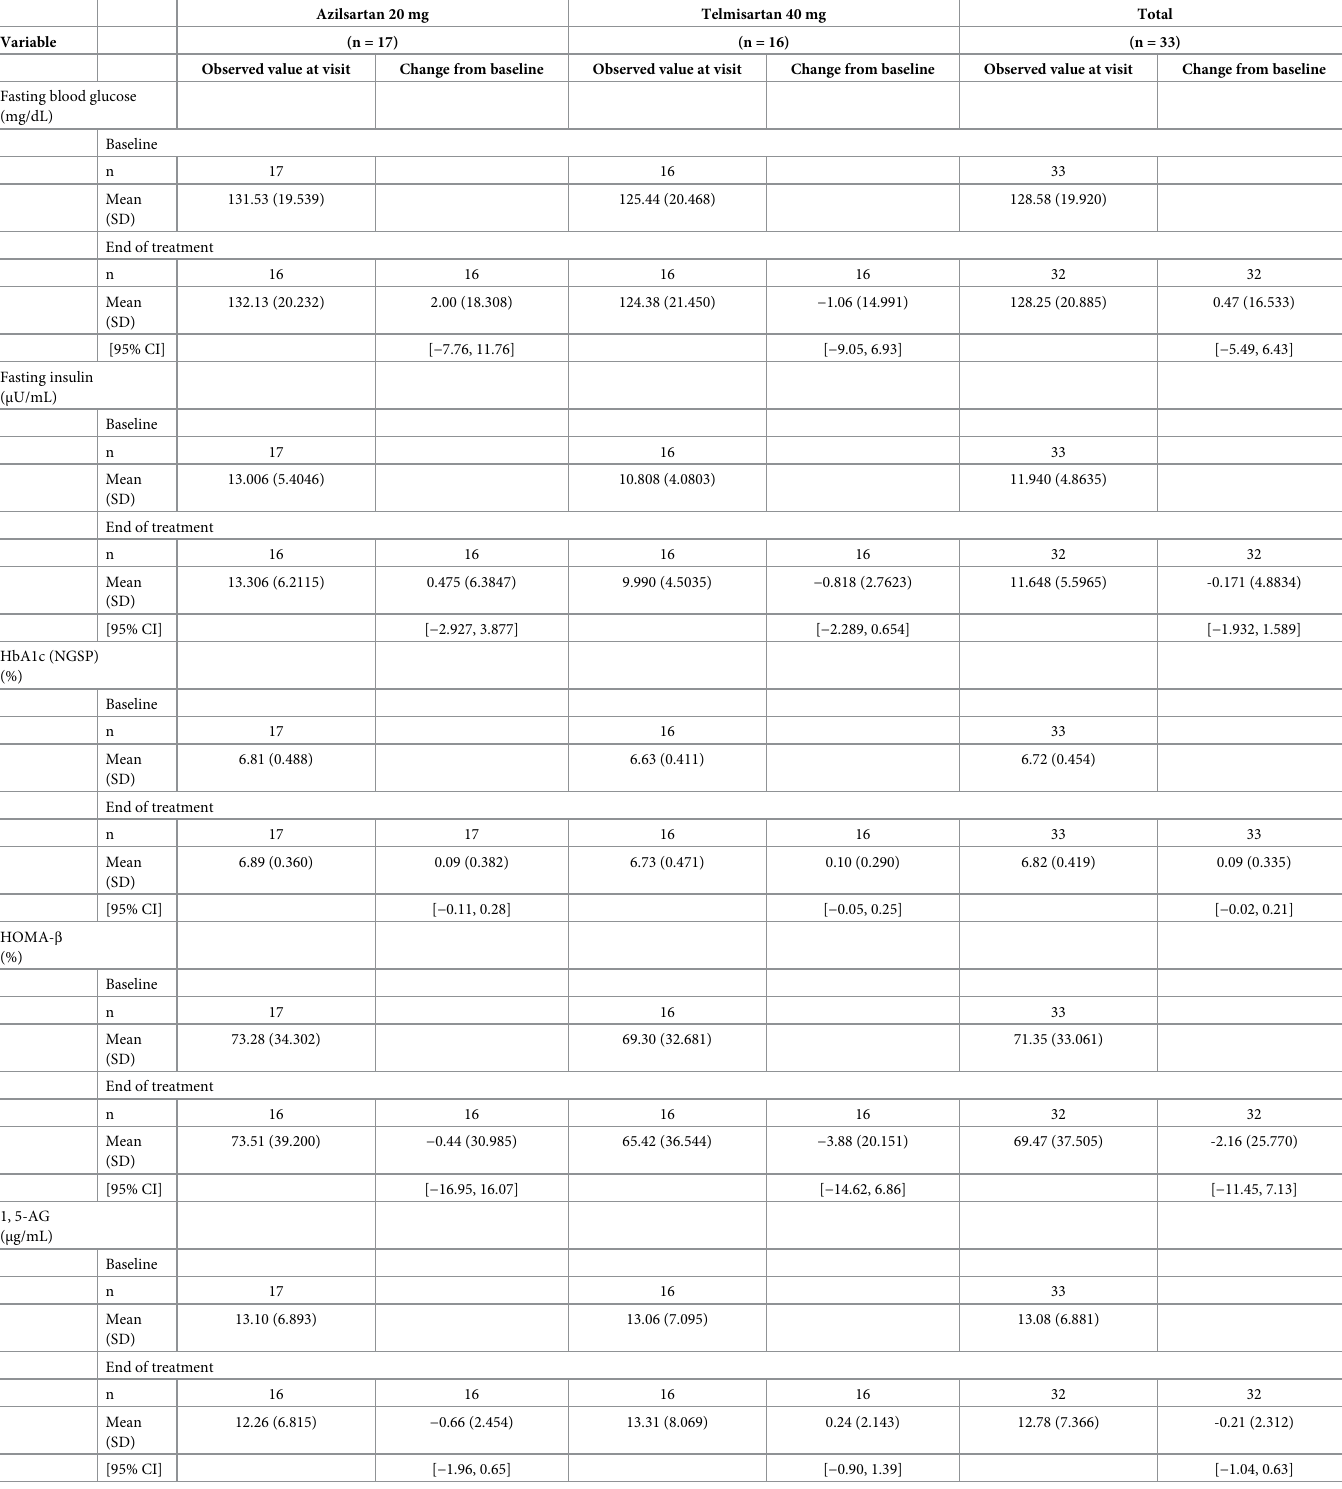
Table 4. Changes from the baseline values in other diabetes-related variables at the end of the treatment period (FAS). Azilsartan